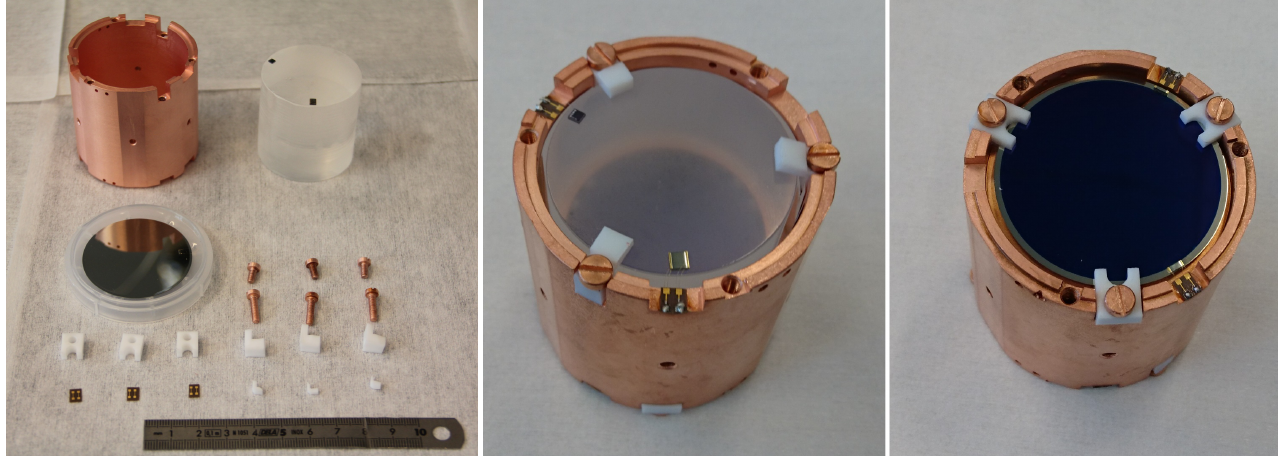
Figure 2. Left panel: A kit of components of a single detector module developed for the CUPID-Mo experiment with 20 scintillating bolometers to search for double-beta decay (DBD) processes in 100 Mo [159,259]. Each module is made of a Cu housing, a 100 Mo-enriched lithium molybdate crystal scintillator ( (cid:11) 44 × 45 mm, ∼ 210 g) and a Ge wafer ( (cid:11) 44 × 0.2 mm, ∼ 1.4 g) with glued small sensors, the Cu screws, the PTFE (polytetrafluoroethylene) spacers and fixing elements, and the Kapton ® film with Au pads. Middle panlel: The assembled CUPID-Mo module, view from the top on the semi-transparent crystal surface with a Neutron-Transmutation-Doped Ge thermistor (3.0 × 3.0 × 1.0 mm) and a P-doped Si heater. A reflective film (Vikiuti TM ) has been put around the lateral side of the crystal. Right panel: The CUPID-Mo module, view from the bottom on the Ge disk equipped with the smaller thermistor (3.0 × 0.8 × 1.0 mm). The wafer is coated with a ∼ 70 nm SiO layer (dark blue internal circle); the 2 mm on the edge of the wafer (17% of the area) remain uncoated. All photos are reprinted with permission from [259]. Creative Commons License CC BY